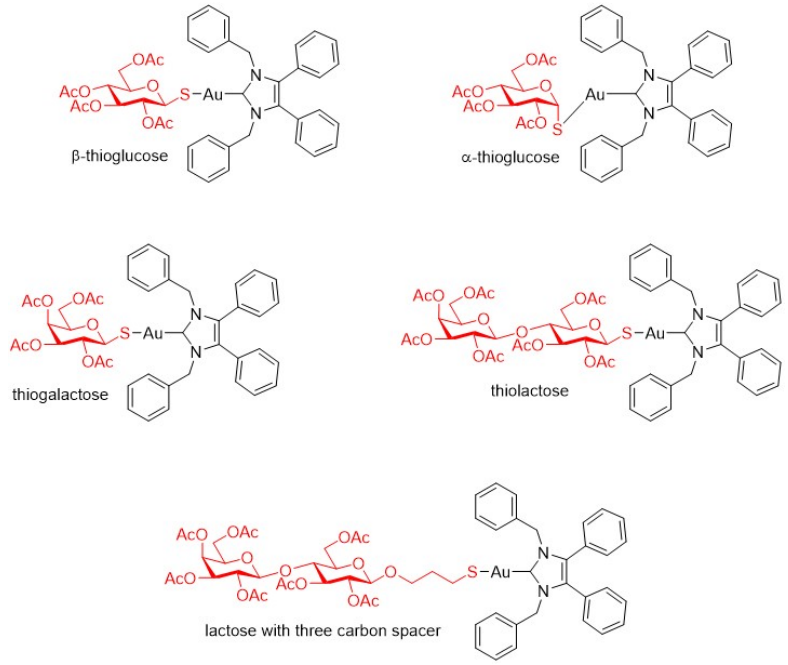
Figure 17. The structures of (1,3-dibenzyl-4,5-diphenyl-imidazon-2-ylidene)gold(I) complexes containing different sugars [110].